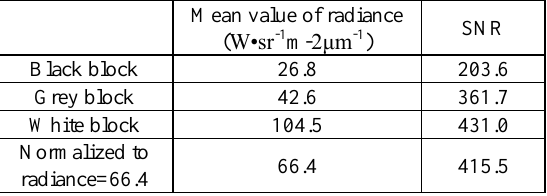
Table 3. SNR for GF-1 panchromatic image (4) Radiometric resolution